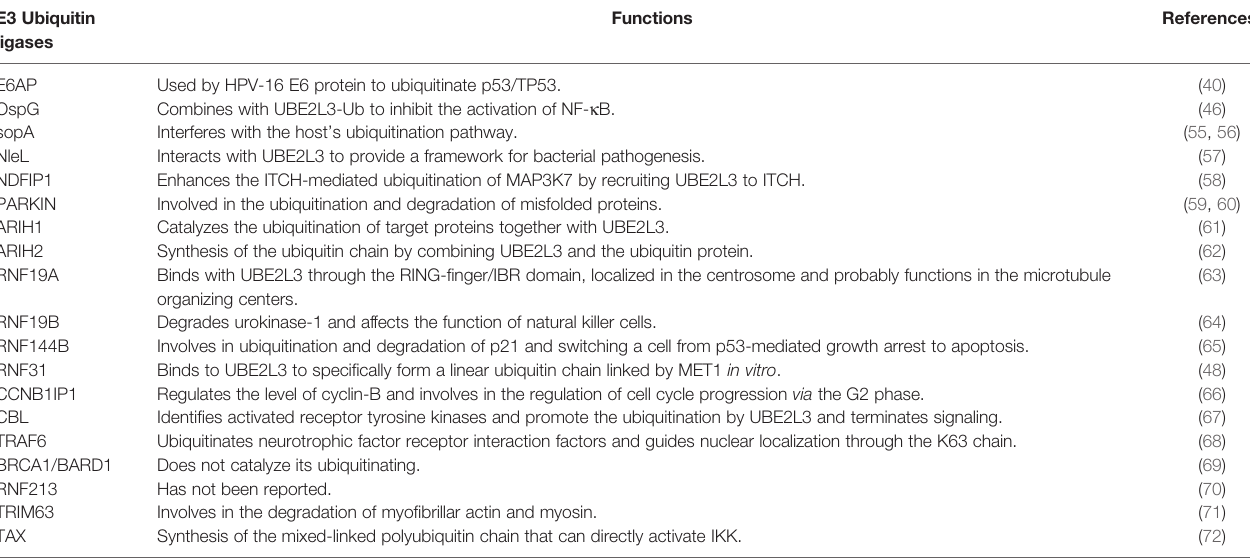
TABLE 1 | The E3 Ubiquitin ligases linked to UBE2L3 and their related functions. E3 Ubiquitin ligases